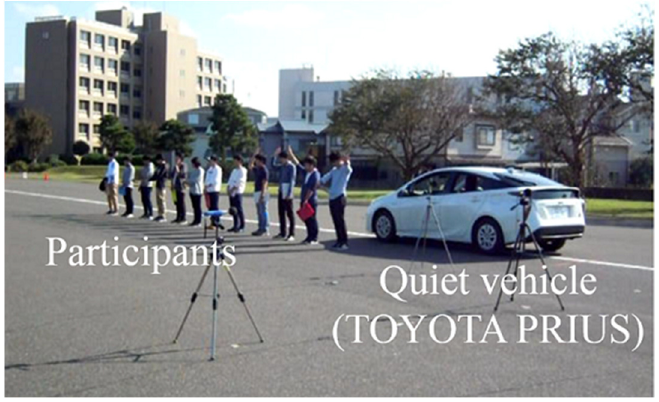
Figure 3. Experimental conditions in Experiment 2.